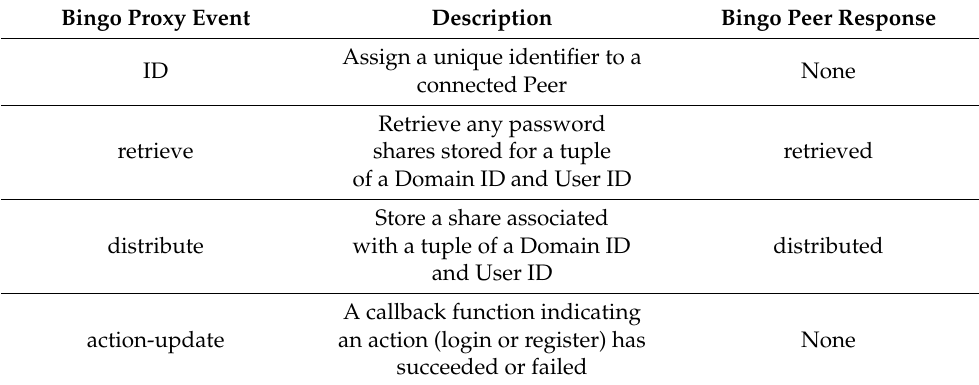
Table 1. BINGO API